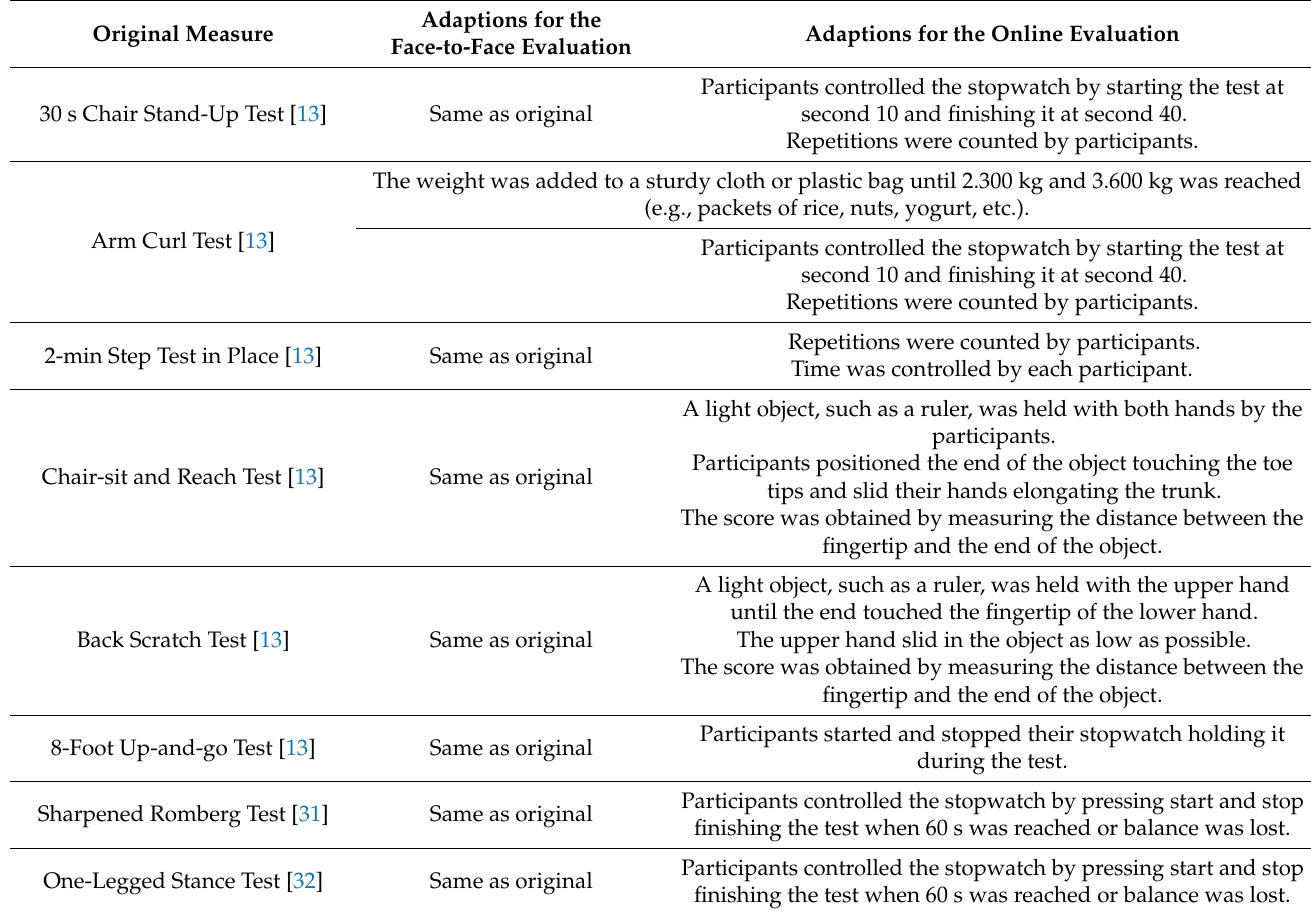
Table 1. Physical and measurement adaptations in the face-to-face and online evaluations for test